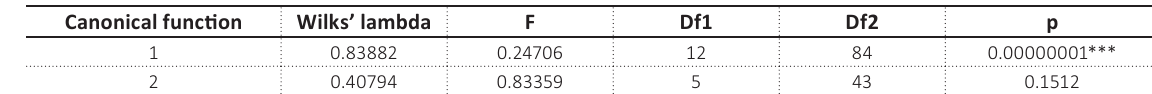
Table 7. Tests of canonical dimensions (the services sector) Canonical